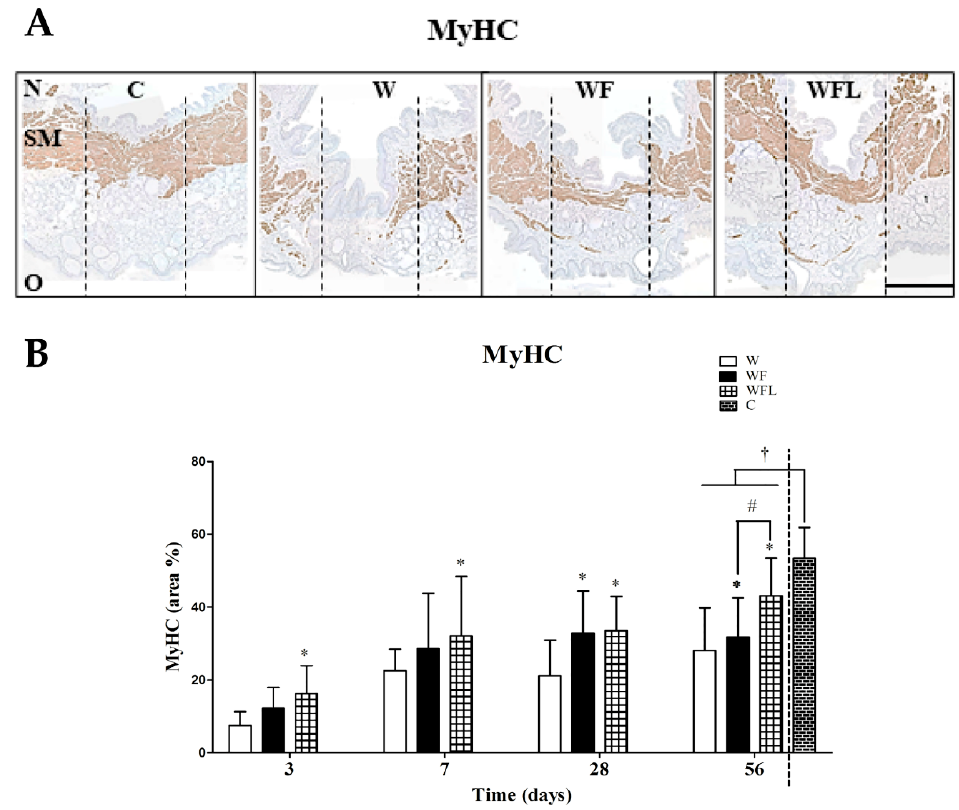
Figure 5. MyHC immunostaining. ( A ) Representative images at day 56. MyHC staining is shown in brown. MyHC expression is almost absent in the central region of the wounds without construct (W). N: nasal side of the soft palate. O: oral side of the soft palate. SM: skeletal muscle layer. The vertical black lines indicate the central region of 700 μ m. The lateral regions of 500 μ m are next to it. Scale bar: 500 μ m. ( B ) Quantification of the MyHC staining. The MyHC area increases from day 3 to day 56 in all experimental groups. At day 56, the stained area in all experimental groups was lower than in the age control. Data are shown as mean ± SD. The areas between the experimental groups were compared in time using a two-way ANOVA and a Bonferroni post-hoc test. Asterisks (*) indicate differences with the control wounds ( p ˂ 0.05). Hash (#) indicates differences between fibrin-only and fibrin plus laminin-nidogen ( p ˂ 0.05). Comparisons between experimental groups and the age control at day 56 (†) were evaluated using a one-way ANOVA and a Bonferroni post-hoc test ( p -value < 0.05).